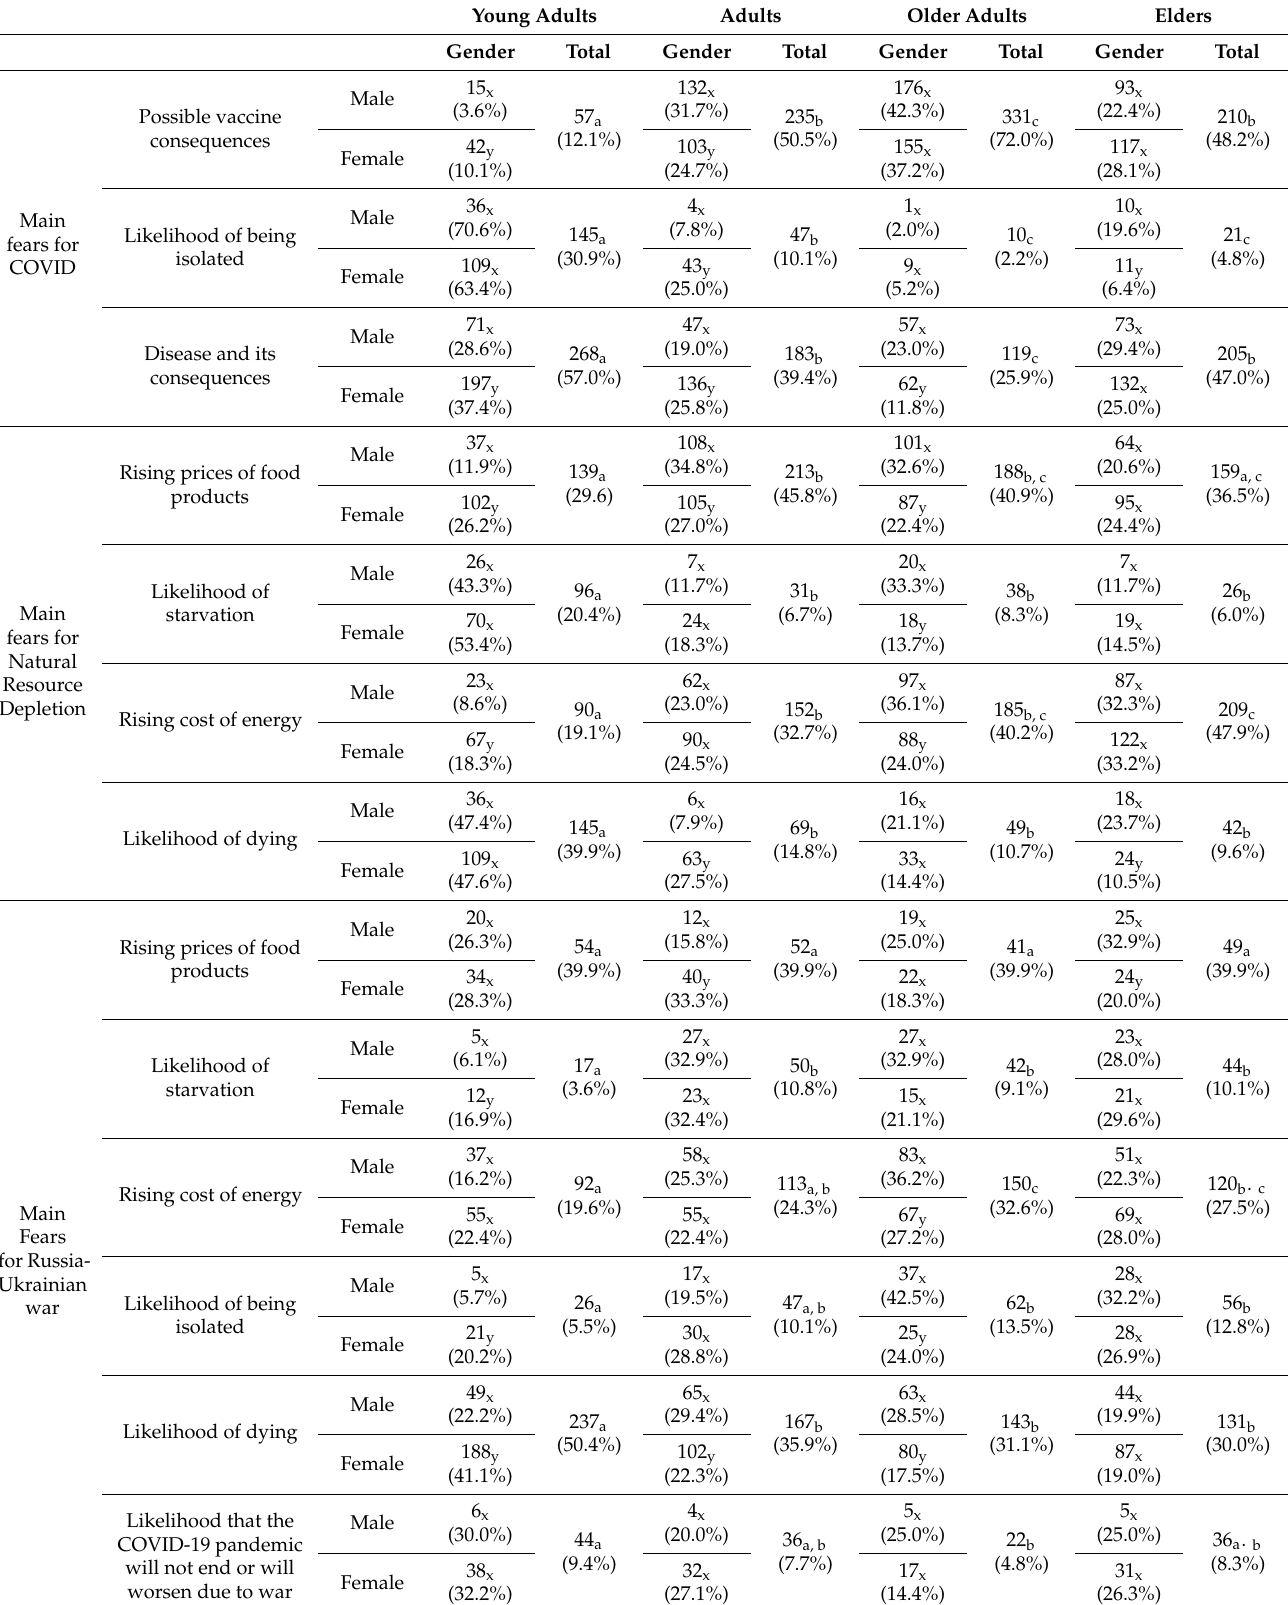
Table 2. Age and gender differences in main fear for COVID-19, Natural Resource Depletion, Russia- Ukrainian war and Climate Change related